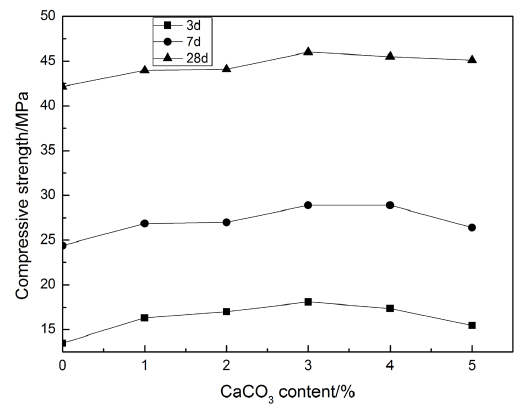
Fig. 2. Compressive strength of steel slag-cement binders with different